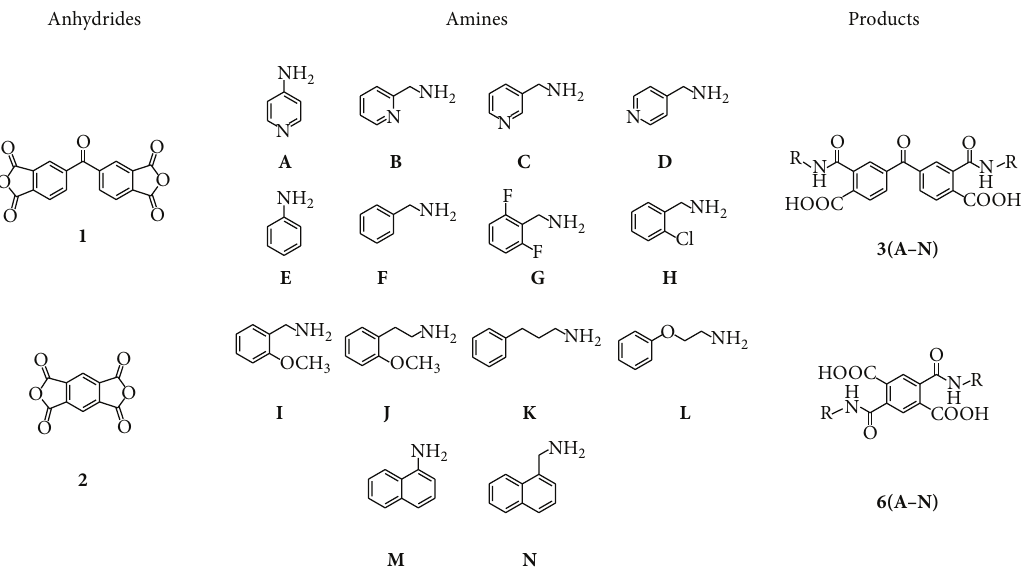
Figure 2: Substrates used for the synthesis of bis(carbamoylcarboxylic)